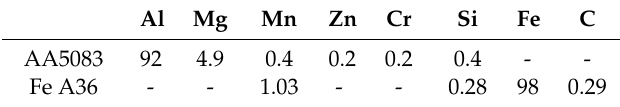
Table 1. Chemical Composition specification (wt. %) of Raw Materials.